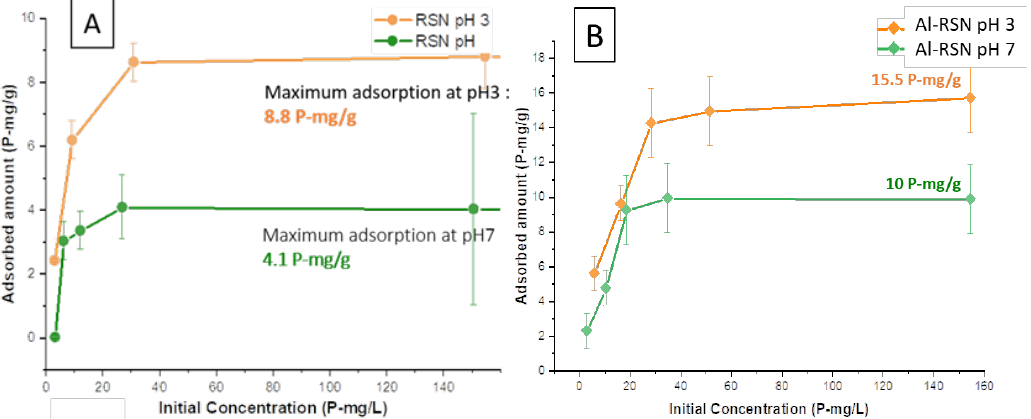
Figure 7. Adsorbed amount of phosphate in different media for 24 h by ( A ) RSNs and ( B ) Al-RSNs. In orange, in water at pH 3; in green, in water at pH 7.